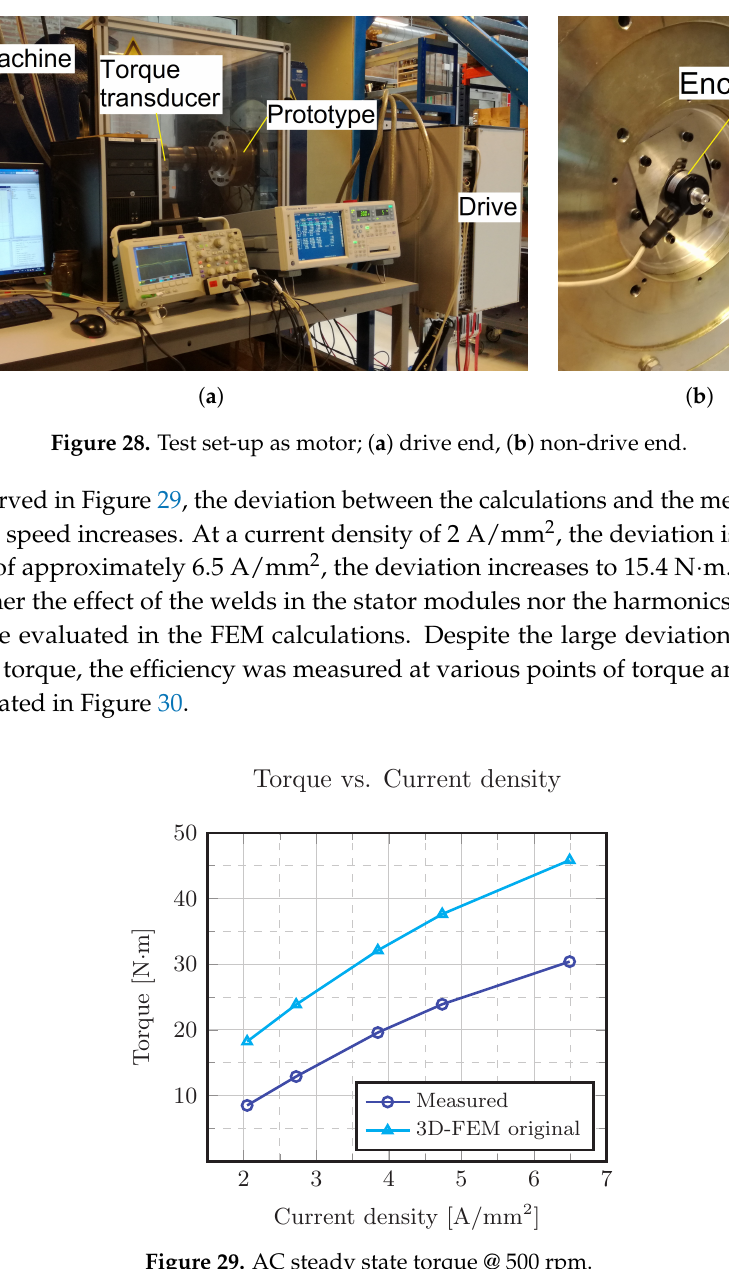
Figure 29. AC steady state torque @ 500